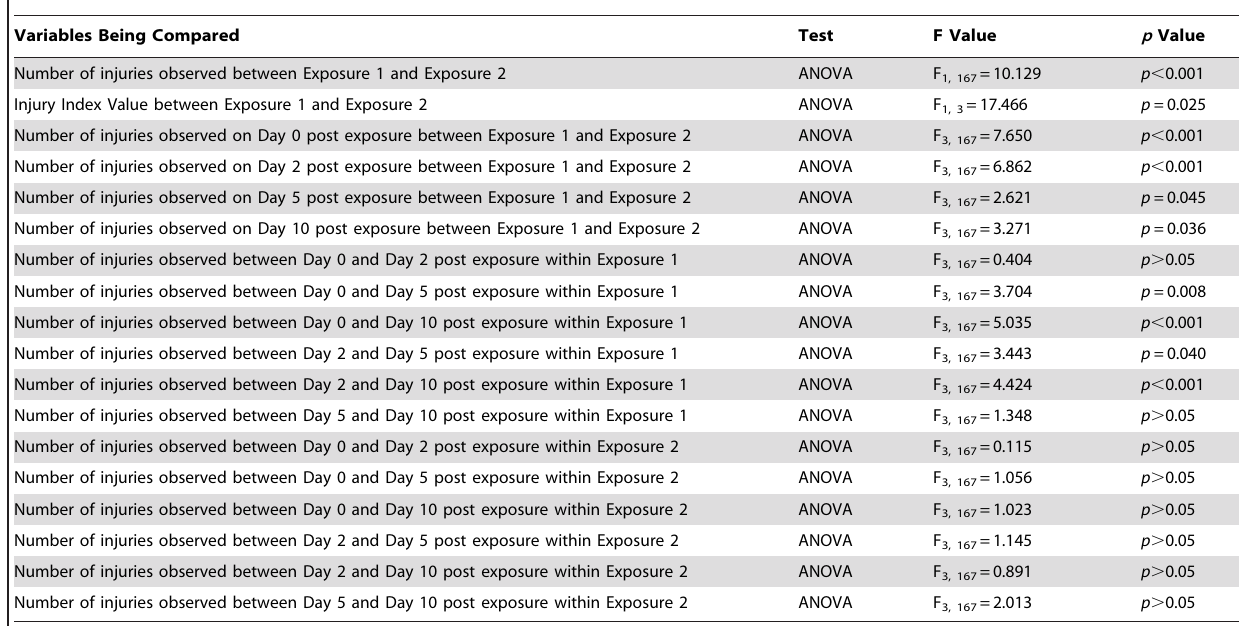
Table 1. Summary of statistical